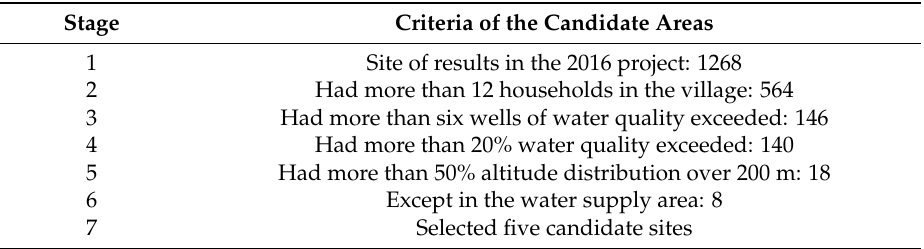
Table 10. Criteria for selecting the candidate areas in